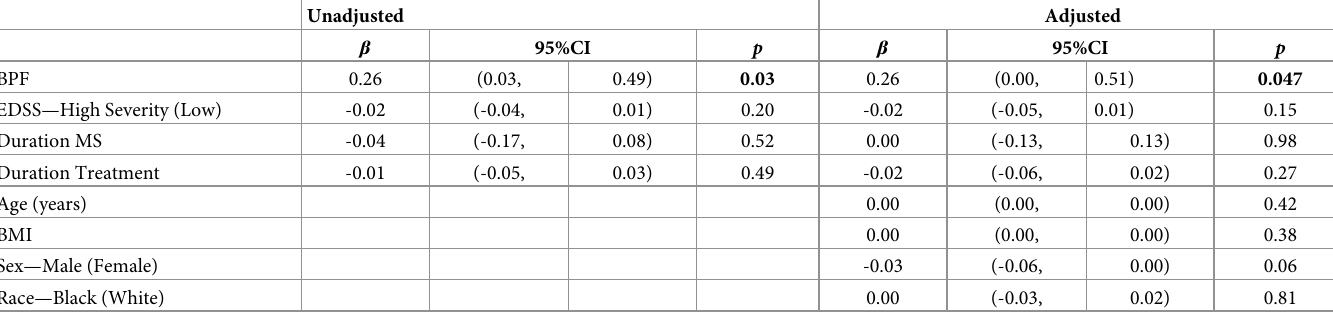
Table 3. Unadjusted and adjusted regression analysis in MS